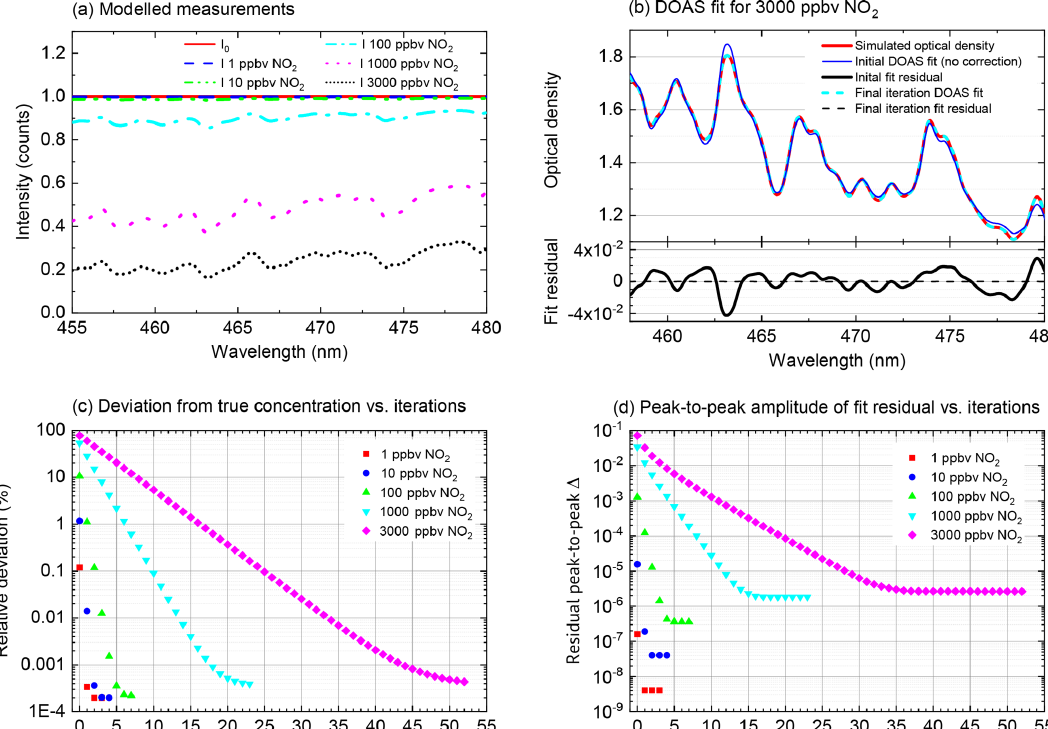
Figure 5. ICAD evaluations of simulated measurements. Panel (a) shows the measured spectra (modelled without photon shot noise) for different NO 2 mixing ratios (see Sect. 3.1). Panel (b) shows DOAS fits for a NO 2 mixing ratio of 3000ppbv. It shows the improvement of the DOAS fit from the initial iteration (fitted concentration of 676ppbv) to the final iteration with optimised fit references (final derived concentration 2999.99ppbv). In the final iteration the NO 2 absorption bands of the simulated optical density are almost perfectly matched, reducing the fit residual by 4 orders of magnitude. The convergence of the retrieved NO 2 towards its true value is shown in panel (c) as a function of the ICAD iteration number. Panel (d) shows the improvement of the fit residual during the iterative evaluation. In a real measurement the achievable noise levels are limited by the fundamental photon shot noise and instrumental error sources (see Sect.